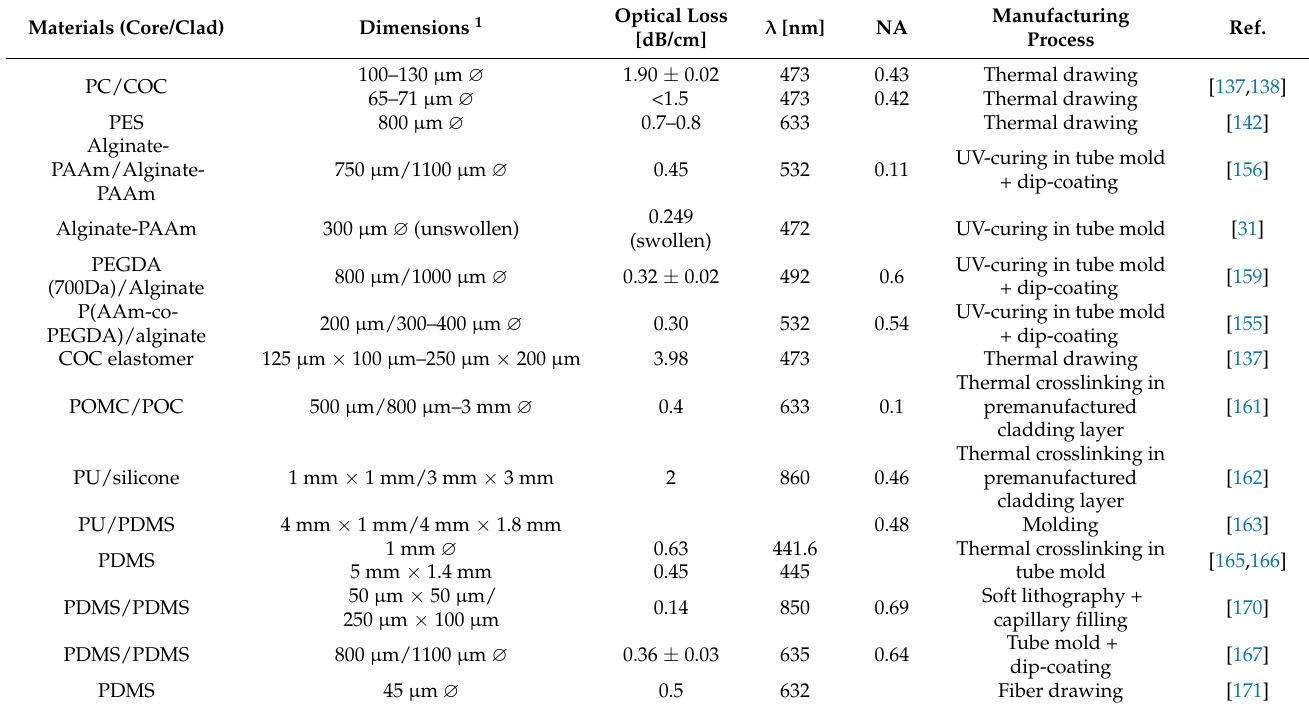
Table 3. Geometrical and optical properties, and manufacturing method of reported optical